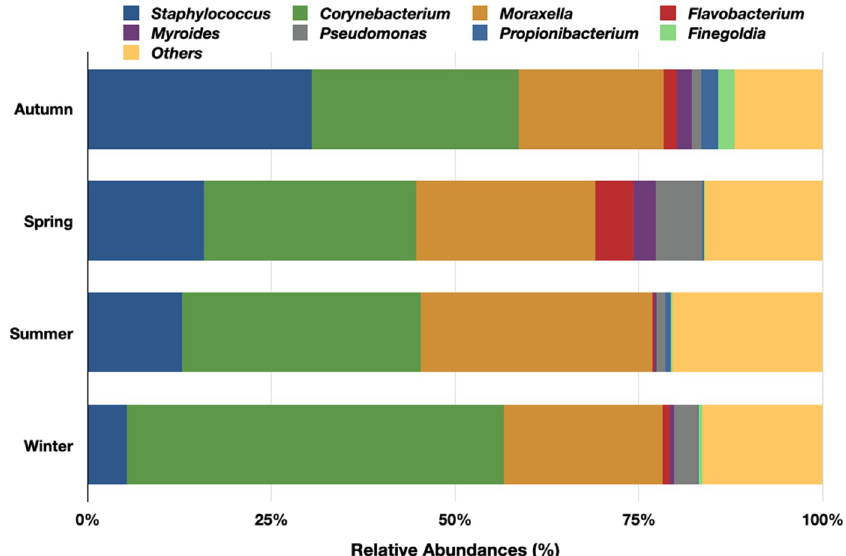
Fig 4. Seasonal variations in the relative abundances of nasal bacterial communities of health care workers of a clinical research laboratory. The predominant genera with RA > 1.0% are presented as stacked bar plots. Genera with RA < 1.0% are combined as Others. The relative abundances are plotted on the X-axis.